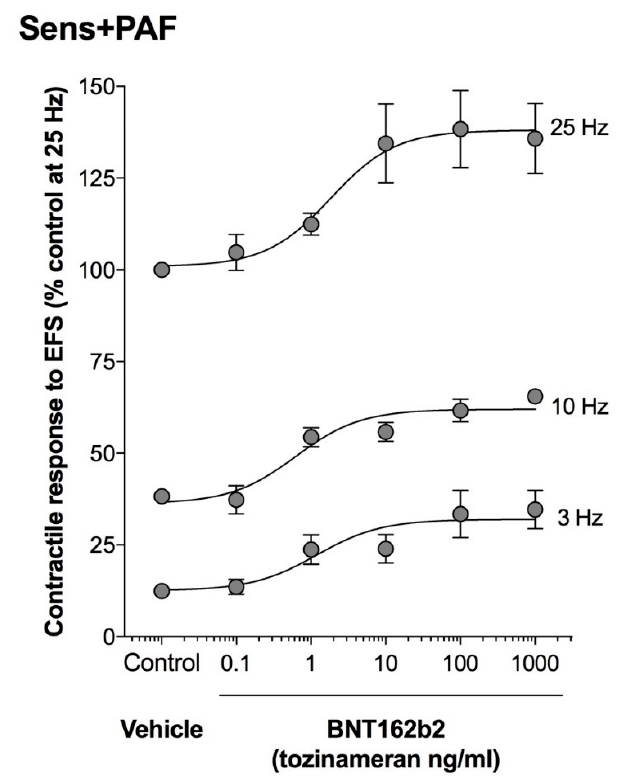
Figure 5. CRCs to BNT162b2 on the parasympathetic contractile response induced by EFS 3–25Hz in sens+PAF isolated airways. Results reported as mean ± SE of n = 5 human isolated sub-segmental bronchi. EFS: electrical field stimulation; PAF: platelet-activating factor; SE: standard error; sens+PAF: passively sensitized plus PAF challenge.